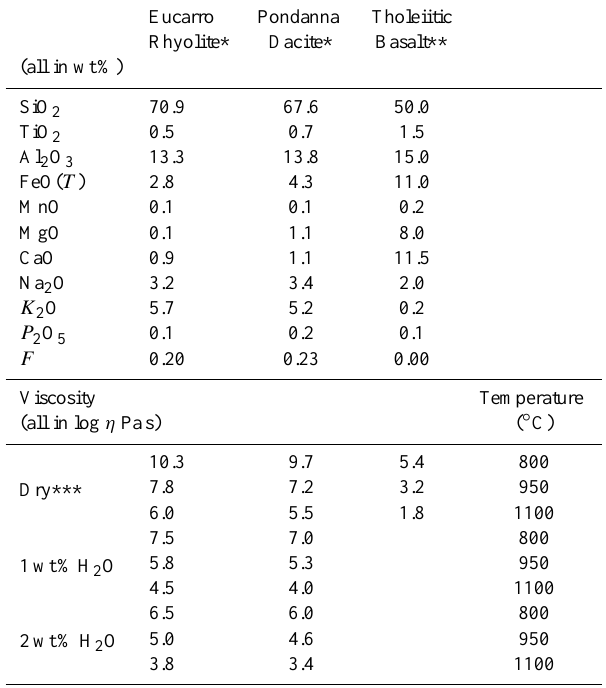
Table 2. Calculated viscosities (log η (Pas)) for the Upper Gawler Range Volcanics with reference to a typical (theoretical) tholeiite composition using the equations of Giordano et al. (2008). Note the ∼ 7 orders of magnitude difference between rhyolitic and basaltic viscosities at their respective typical eruptive temperatures, com- pared with the ∼ 1 order of magnitude between calculated Gawler Range Volcanics at 1100 ◦ C with ∼ 2.2wt% total volatiles and a typical tholeiitic basalt composition at typical eruptive